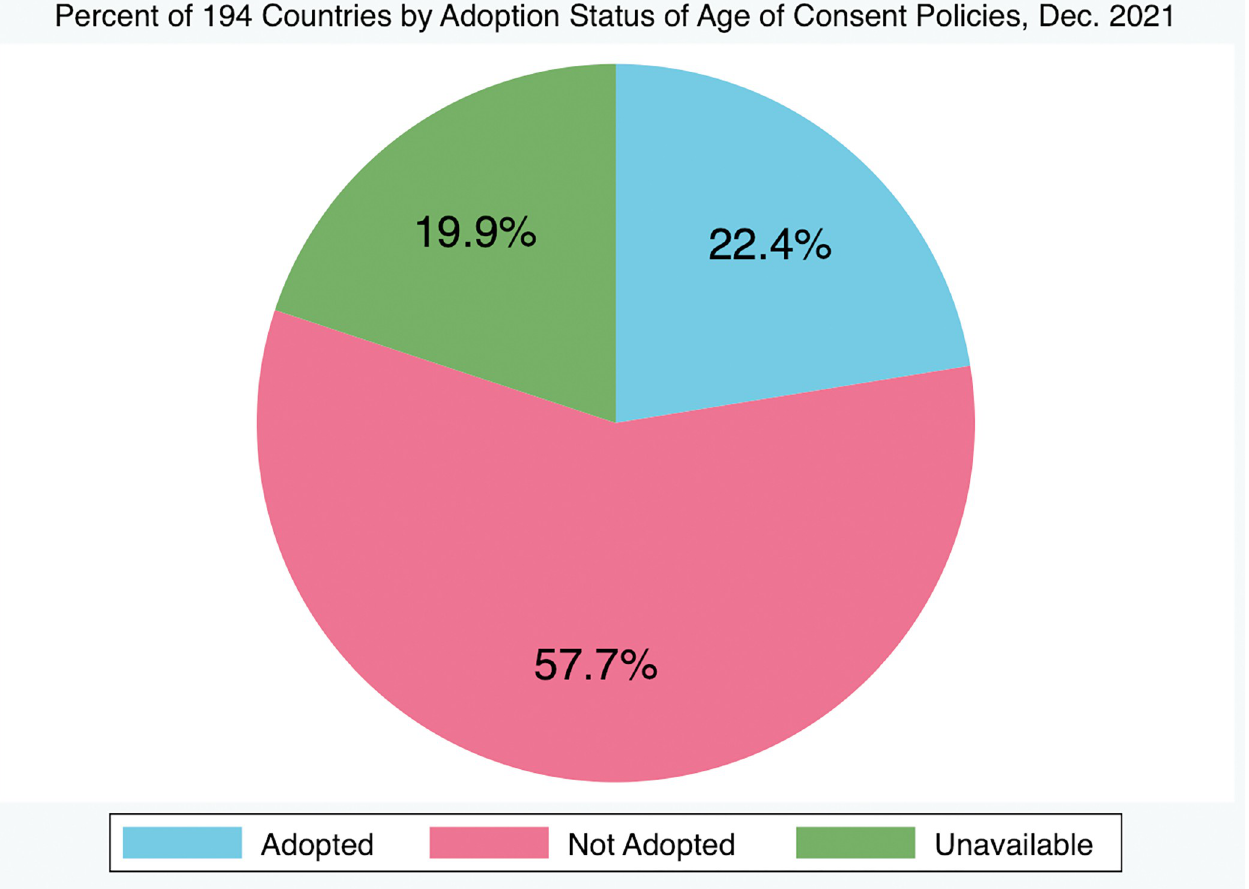
Fig 2. Percent of 194 countries by adoption status of age of consent policies, Dec. 2021. 22.4% of 194 countries have adopted policies authorizing lowered age of consent to HIV testing and treatment services in-country, 57.7% have not adopted, and information is unavailable for 19.9% of countries, as of December